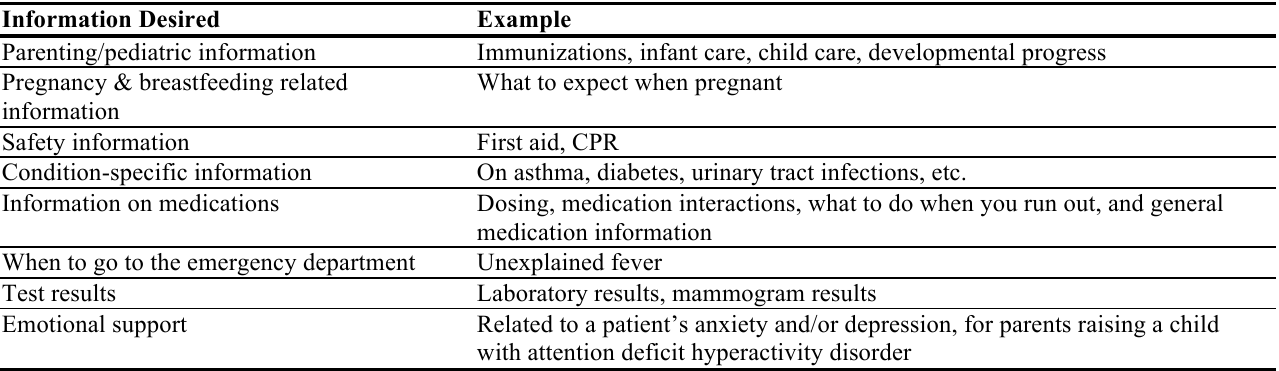
Table 2. Health Information desired by patients between